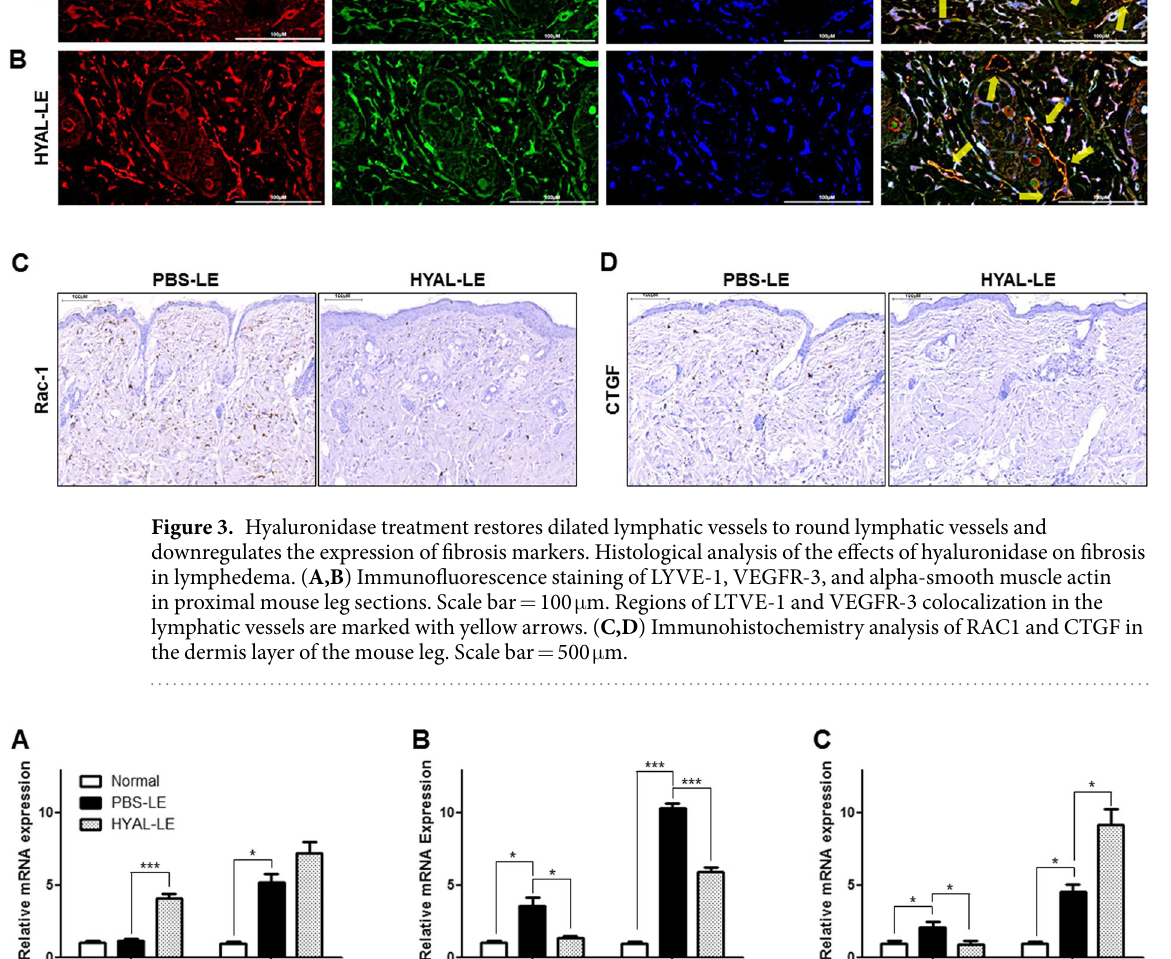
Since our data indicated that hyaluronidase injection inhibited dermal fibrogenesis in mice with lymphedema, we performed quantitative real-time polymerase chain reaction analysis to further investigate the preventive effects of HYAL on fibrogenesis. First, the expression of matrix metallopro- teinase (MMP) was analyzed to determine if HYAL injection inhibits collagen synthesis and stimulates collagen degradation. The expression levels of MMP3 and MMP9, two enzymes that degrade the extracellular matrix, were both increased by HYAL injection (4-fold and 1.3-fold, respectively) (Fig. 4A). To evaluate the extent of the preventive effect of HYAL on fibrogenesis, the mRNA expression levels of vascular endothelial growth factor D (VEGF-D) and fibronectin were also investigated (Fig. 4B). VEGF-D expression was 0.4-fold lower in the HYAL-LE mice compared to the PBS-LE mice; similarly, fibronectin expression was downregulated 0.3-fold in the HYAL-LE mice compared to the PBS-LE mice. In addition, α -SMA, a major marker of fibrosis, was decreased in